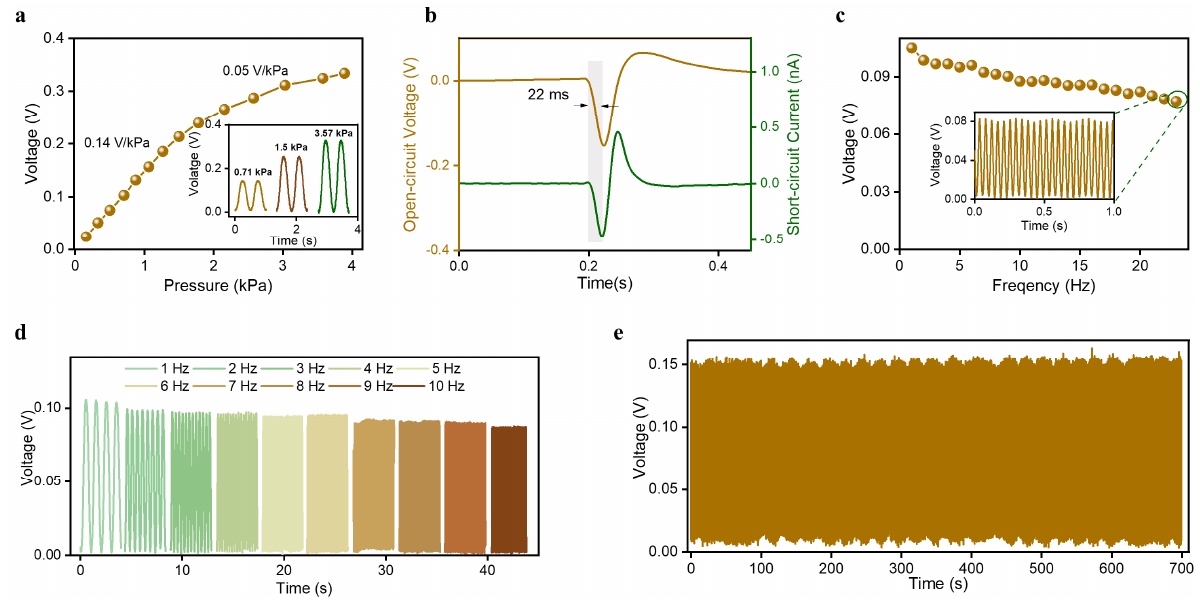
Figure 2. The output performance of the sensor. ( a ) The pressure sensitivity of the designed sensor. The inset shows the output waveforms of the sensor under three different pressures (0.71 kPa, 1.5 kPa, 3.57 kPa). ( b ) Response time characterization of the sensor. ( c ) The open-circuit voltage of the sensor under a pressure of 0.7 kPa at frequency of 1 − 23 Hz. The inset shows the output waveforms of the sensor (0.7 kPa, 23 Hz). ( d ) The output signals of the sensor under the same pressure with frequency ranging from 1 to 10 Hz. ( e ) The stability of the sensor under a pressure of 1.24 kPa with a frequency of 10 Hz.